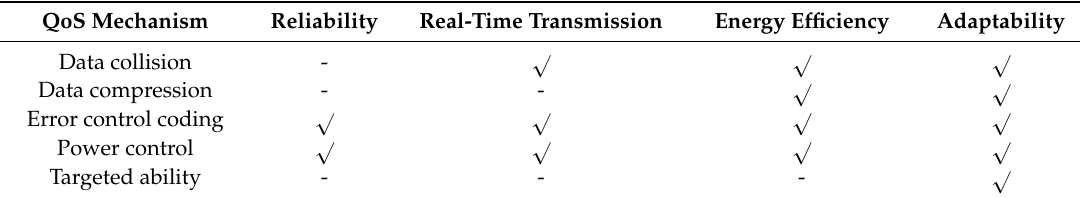
Table 9. QoS Mechanism Solutions Based on